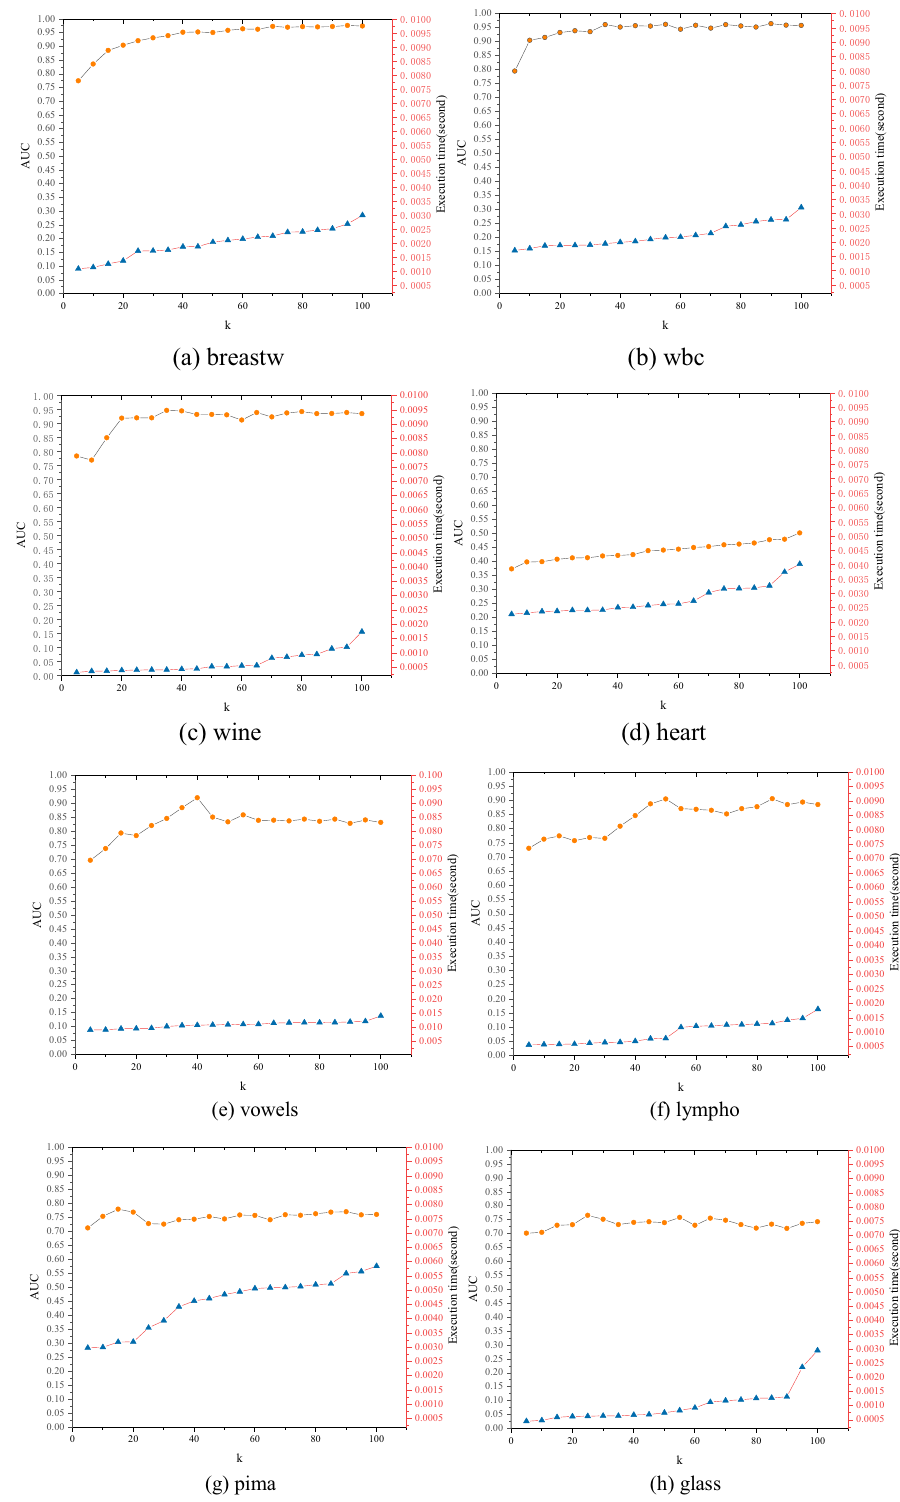
Figure 11. FBOD AUC performance (y1-axis) and execution time (y2-axis) versus the different neighbors’ k